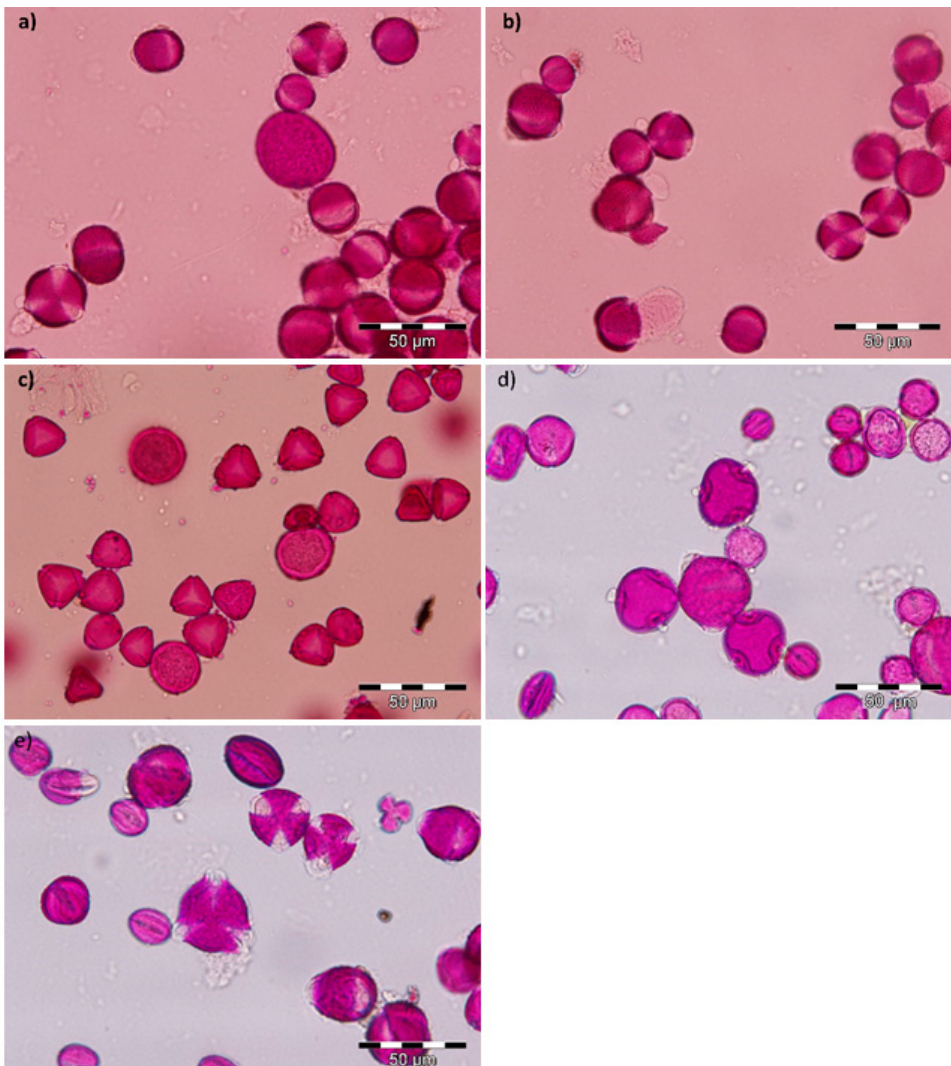
Figure 1. Microscopy photos of samples from BB Romania and India—showing the main pollens found. ( a ) Brassica sp. (Romania, July 2016), ( b ) Brassica sp. ( India, June 2016), ( c ) Eucalyptus sp. (India, June